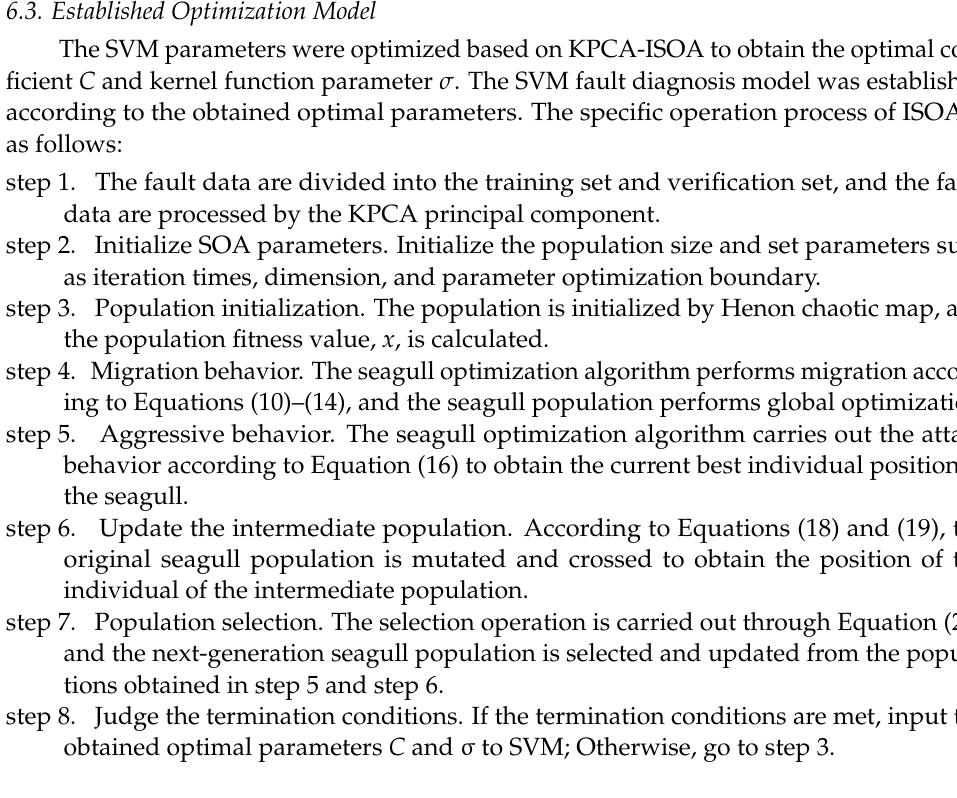
Figure 7. The cumulative contribution rate of the principal component